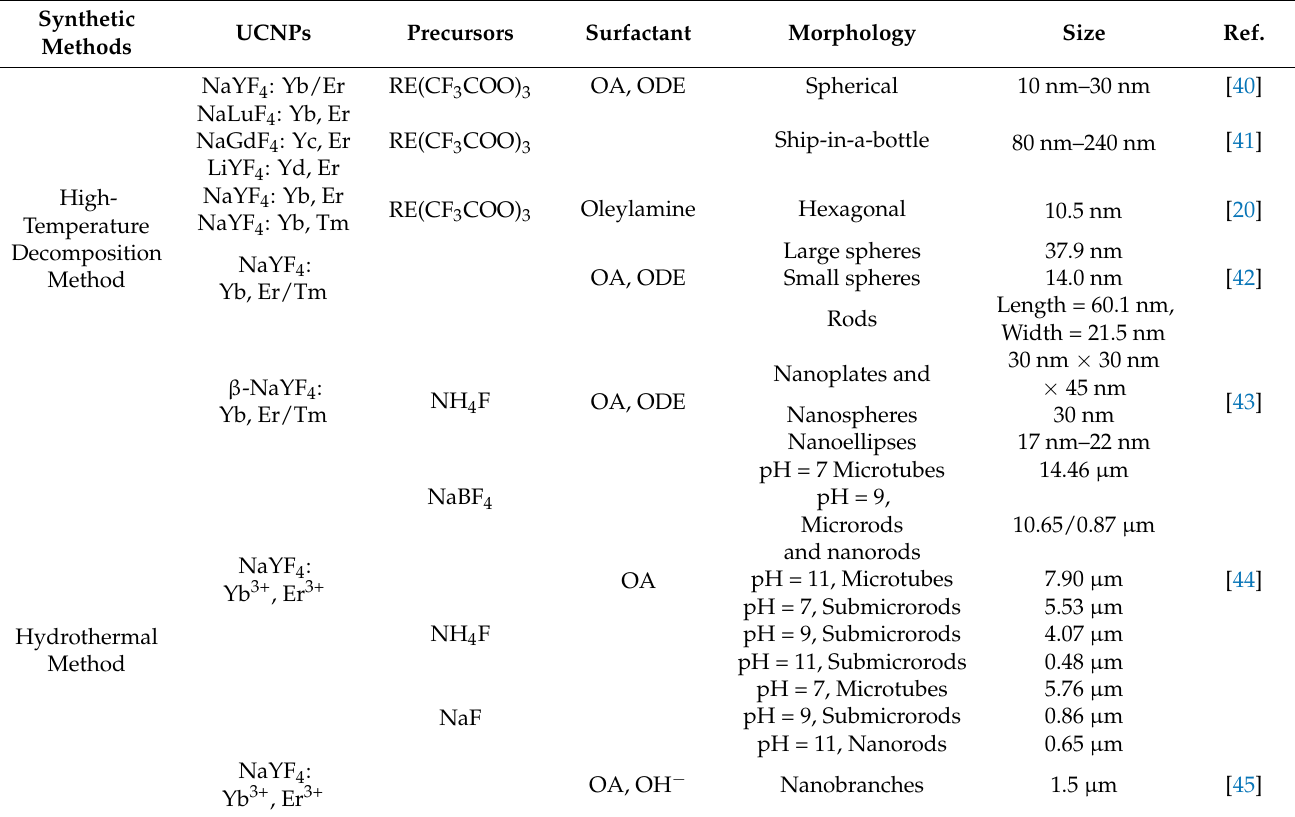
Table 1. Design of the UCNPs analysis